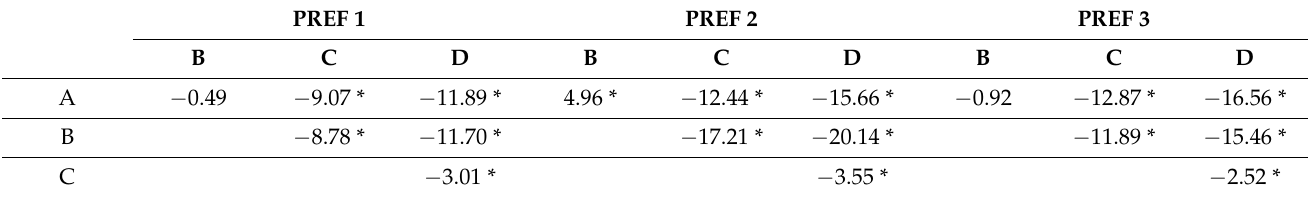
Table 4. Correlation between forest development and preference levels (U Mann–Whitney test for pairs of forest types).